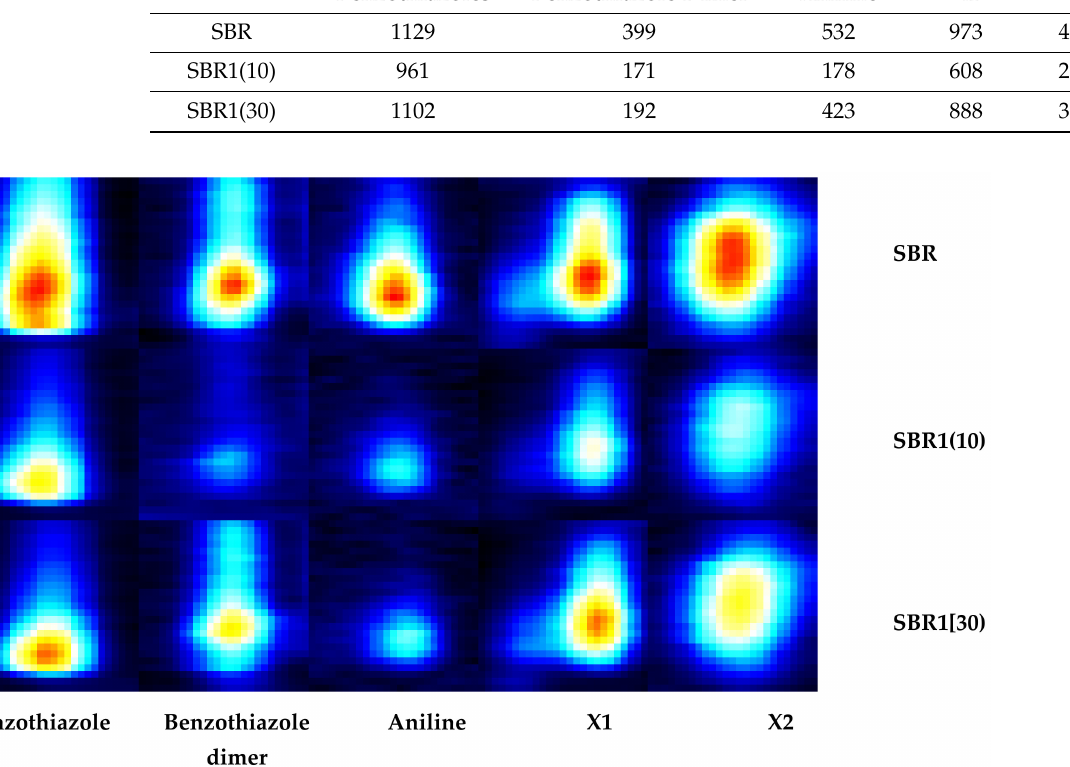
Figure 9. Graphical representation of VOCs released during the vulcanization